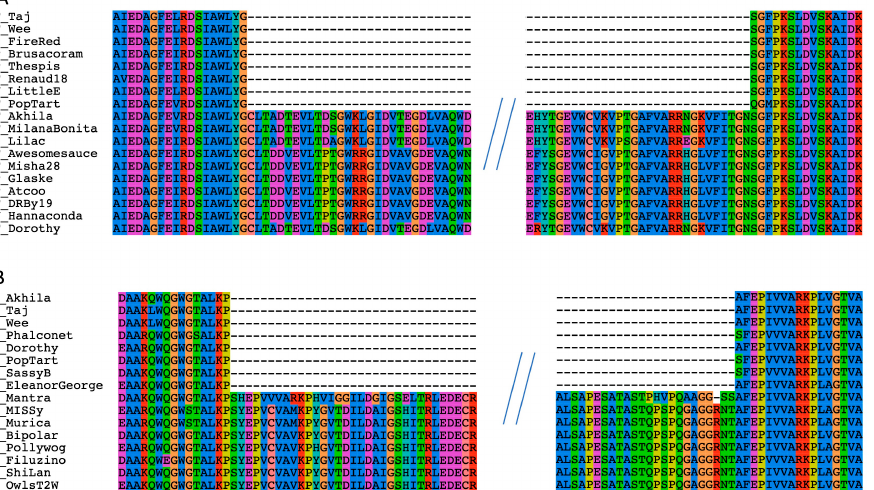
Figure 2. Alignment of the beginning and end of the intein (panel A ) and the ShiLan domain (panel B ) with their associated surrounding regions. In the Dorothy phage, the intein is 327 amino acids long. In the ShiLan phage, the ShiLan domain is 202 amino acids long.